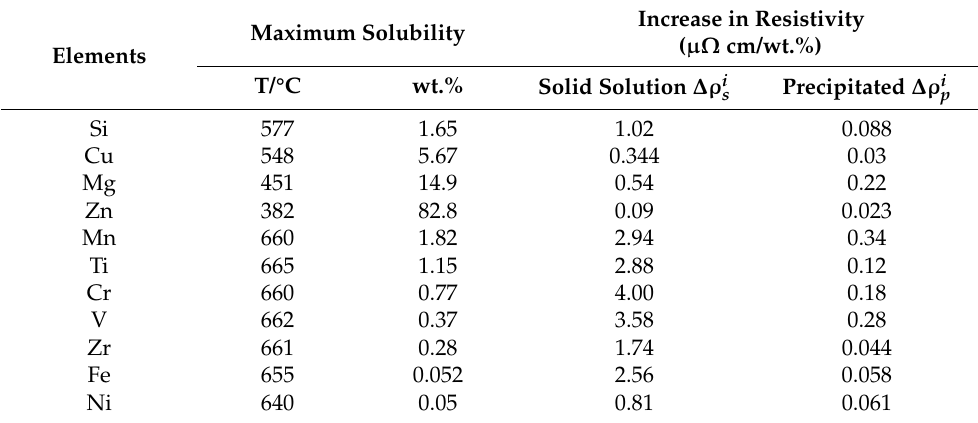
Table 3. Solid solubilities of alloying elements in aluminum and the effect of alloying elements on the resistivity of pure aluminum